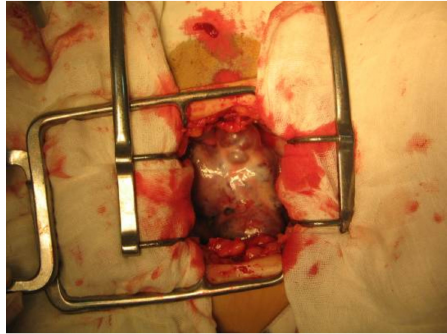
Figure 5. Intra-operative